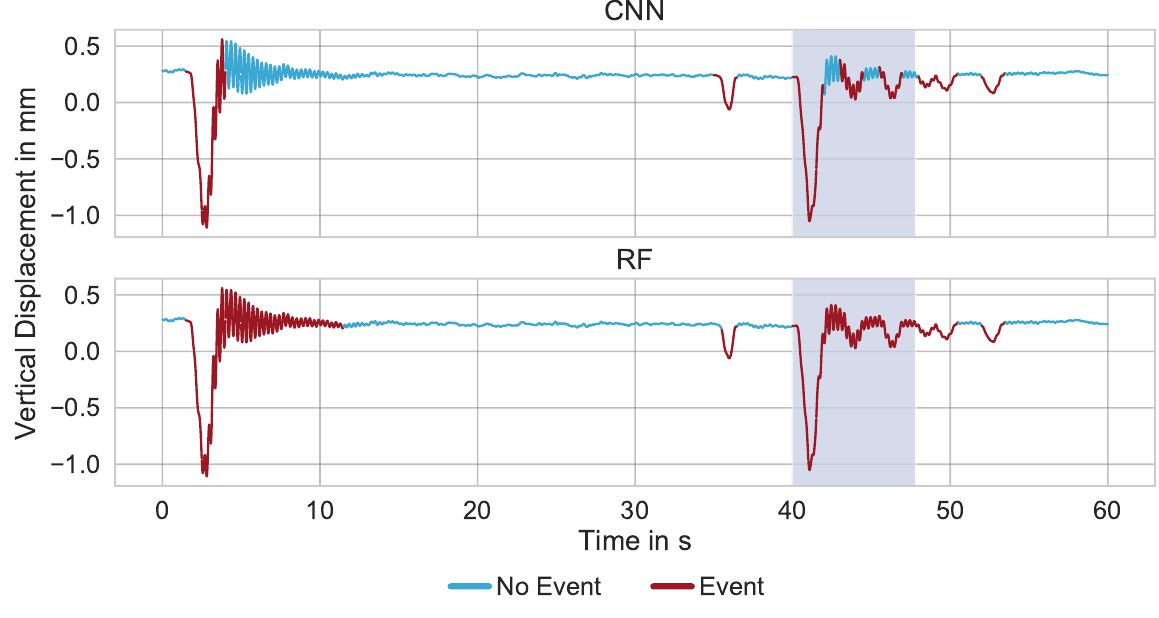
Figure 5. Classification results of an exemplary, 60s long section of bridge A for CNN (upper) and RF (lower). The measurement campaign from which this section originates is unknown to the model. The highlighted area corresponds to the excerpt depicted